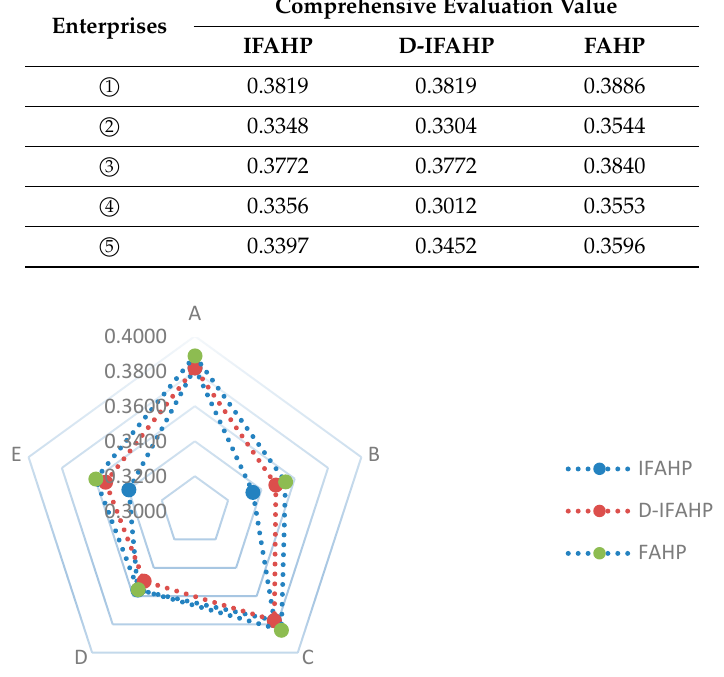
Table 11. Comprehensive evaluation value of different evaluation methods.